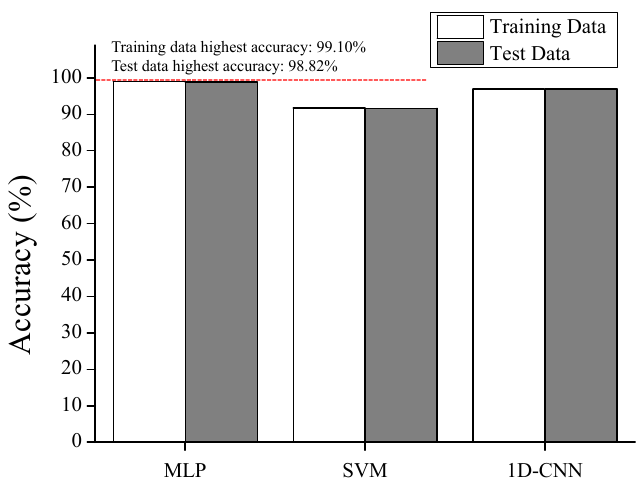
Figure 10. Accuracy of S 2 .